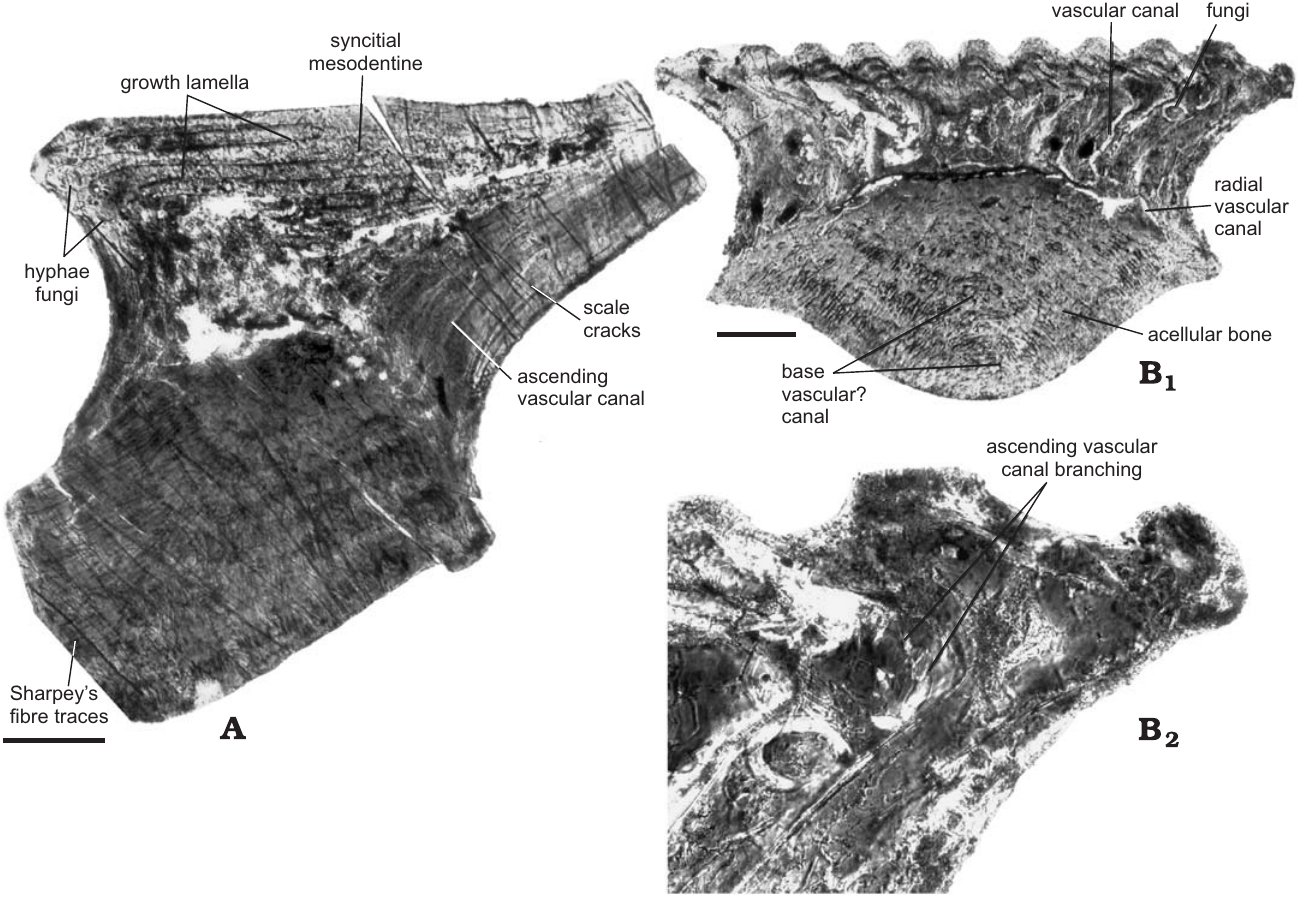
Fig. 9. Diplacanthid acanthodian Milesacanthus sp. aff. M. antarctica Young and Burrow, 2004 from early Frasnian, horizon GI4 of an unnamed